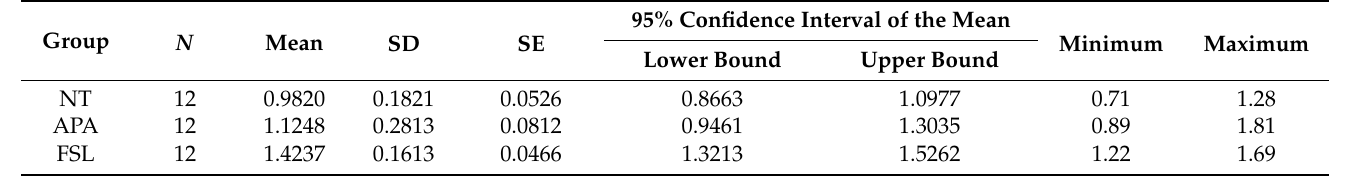
Table 1. Statistical description of surface roughness of the three surface treatment groups ( µ m). Group N